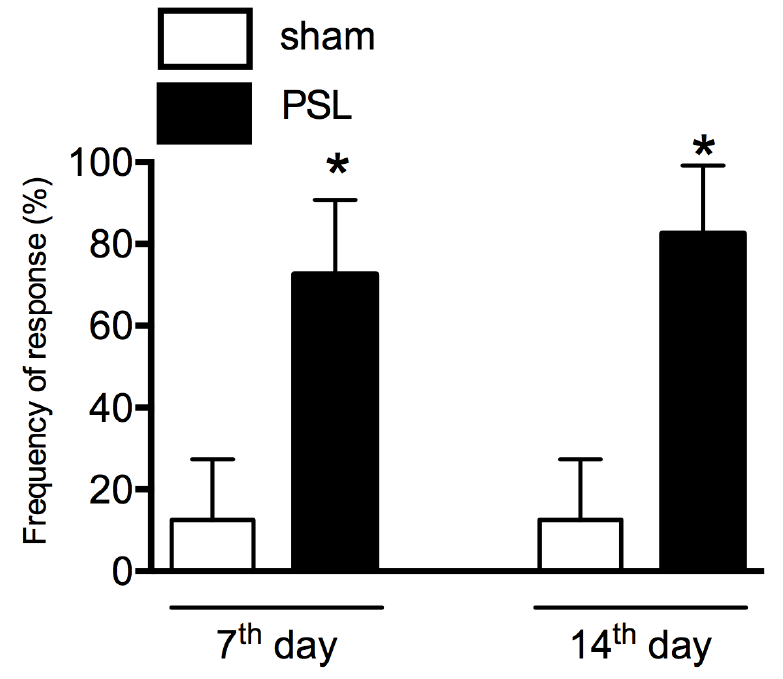
Figure 1. Efficacy of the PSL model to cause a neurophatic pain